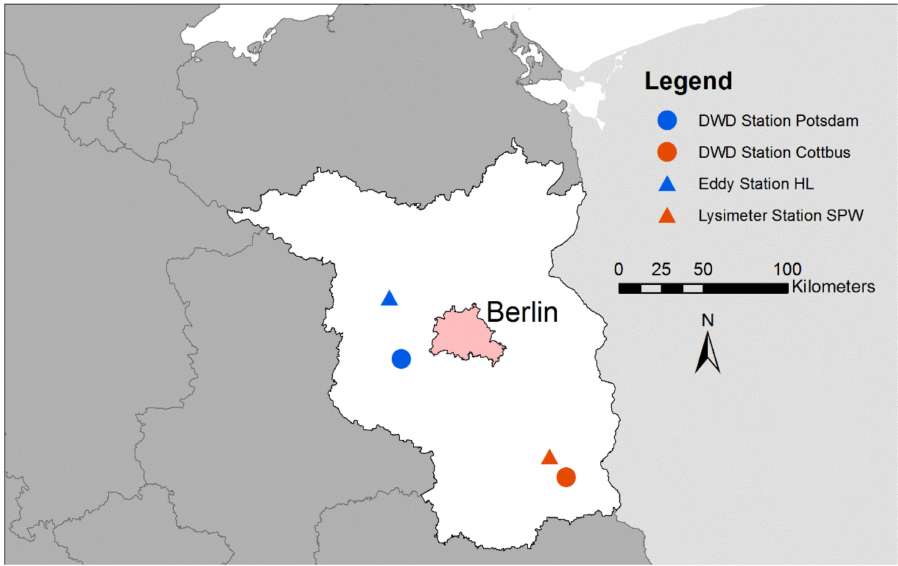
Figure 1. Location of study sites Havelländisches Luch (HL) and Spreewald wetland (SPW) and nearest